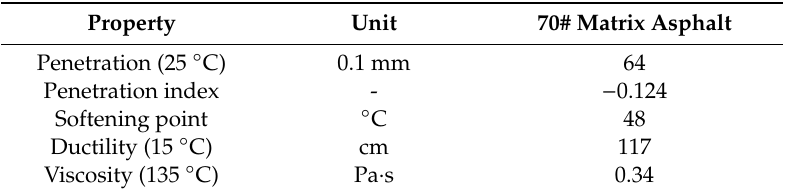
Table 1. Basic properties of 70# matrix